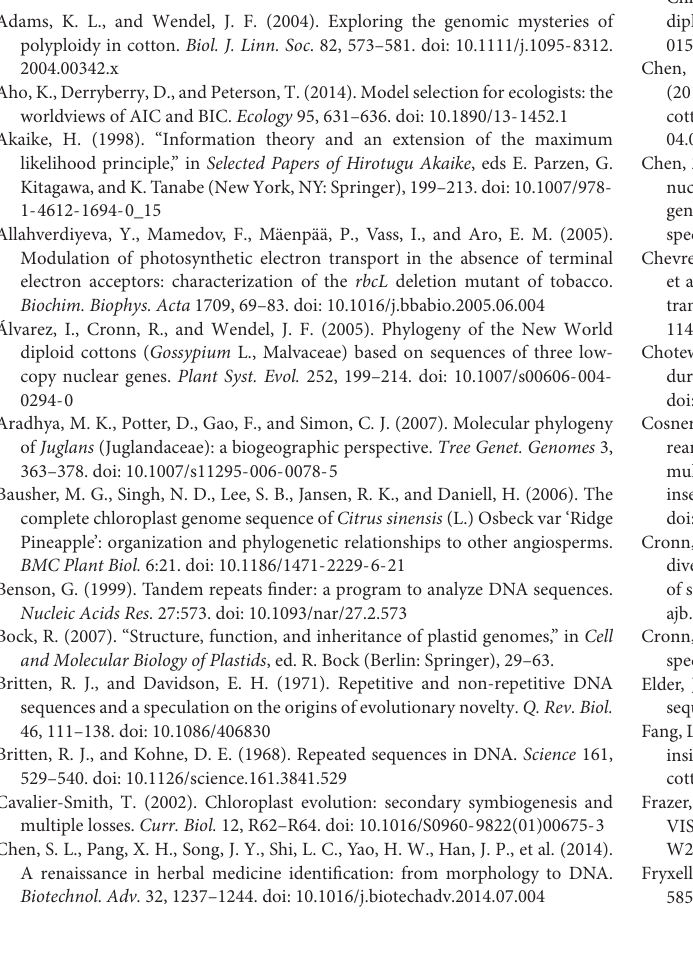
TABLE S4 | List of genes present in six Gossypium chloroplast genomes.